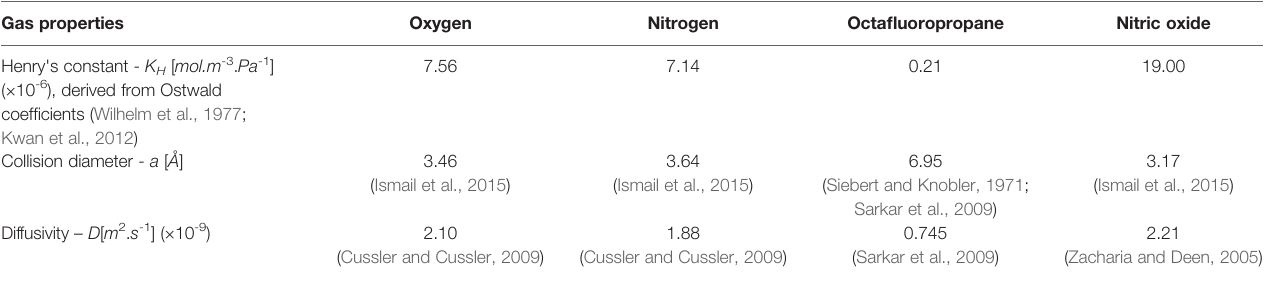
TABLE 1 | Gas properties used in the